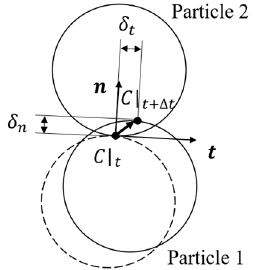
Figure 1. Particle overlap definition.